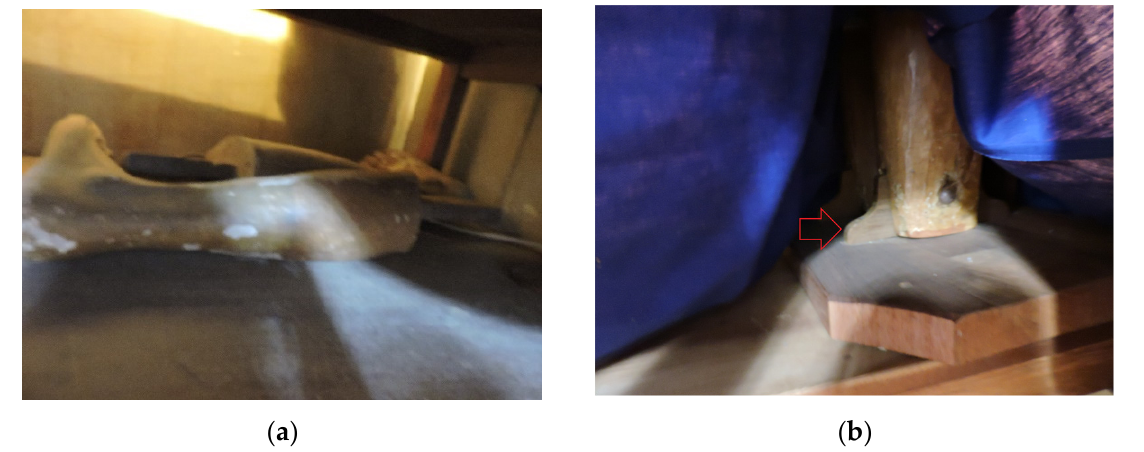
Figure 9. ( a ) Blocks of the legs. ( b ) Detail of the thighs fixed to the base. Photos by Lia Brusadin, 26 December 2016.